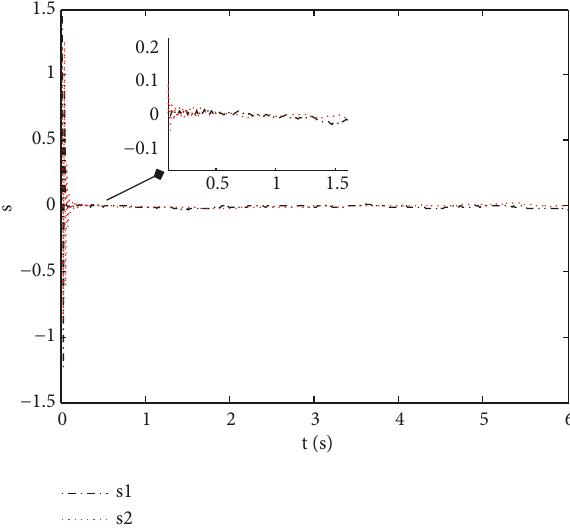
Figure 5: Convergence curves of sliding mode surface function.